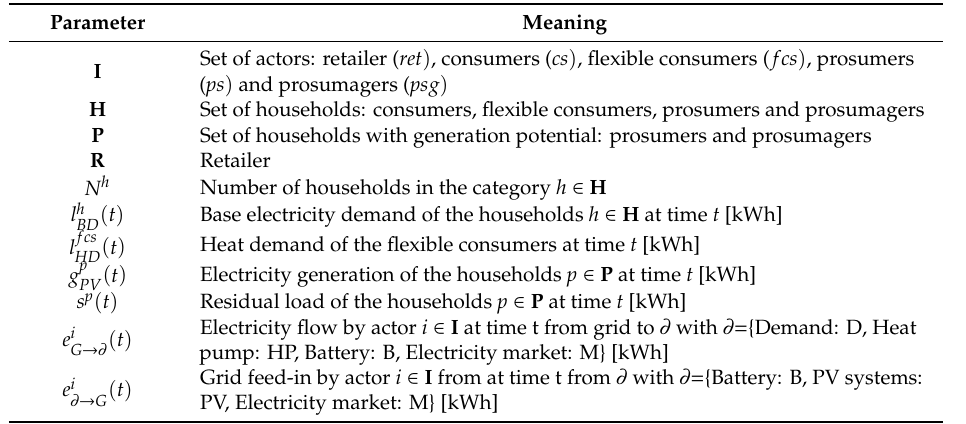
Table A1. Table of